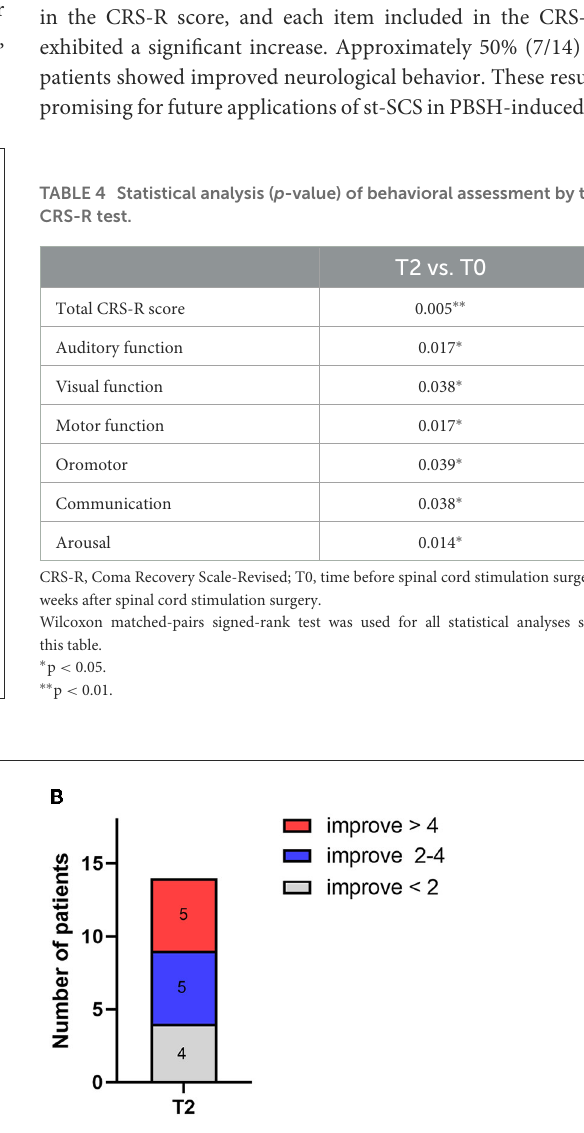
FIGURE3 Number of patient changes in CRS-R score after 2 weeks of treatment (T2). (A) The number of patient changes for the efficacy group (CRS-R score increased by ≥ 2) and the inefficacy group (CRS-R score unchanged or increased by < 2). (B) Detailed number of patients and the corresponding change in CRS-R